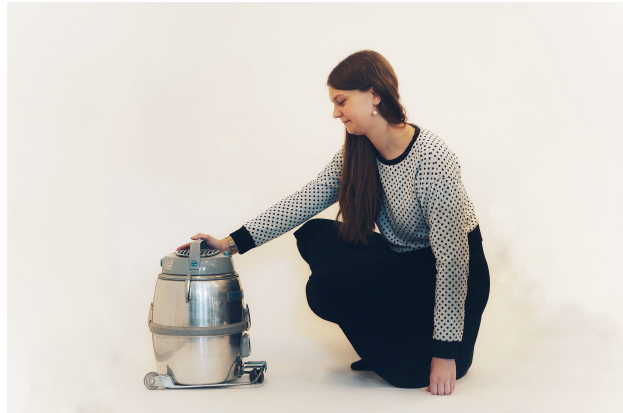
Figure 2. Human actor in close and emphatic contact with an FDO robot, whose body is borrowed from an old-fashioned vacuum